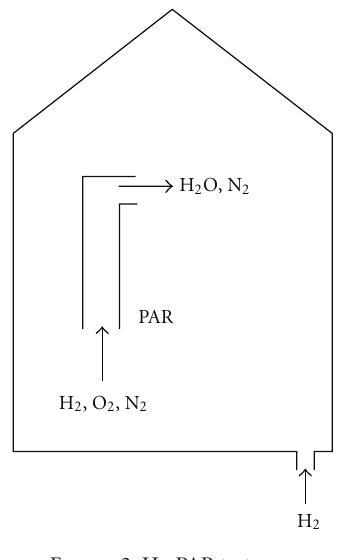
Figure 2: H 2 -PAR test case.